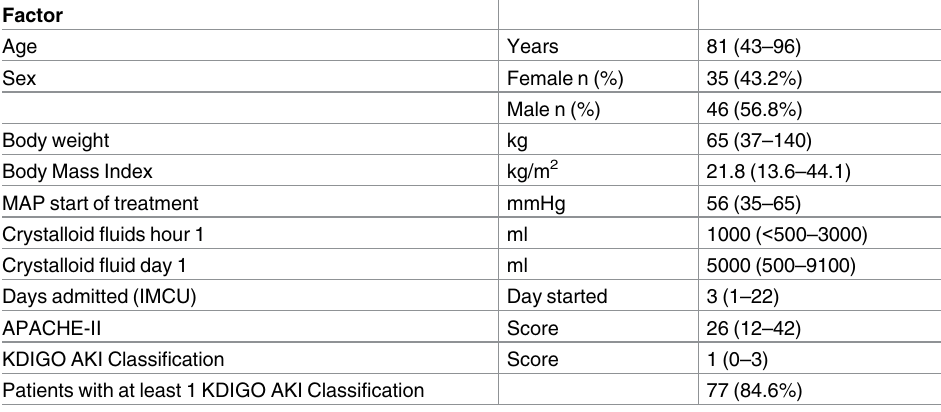
Table 1. Patient characteristics. Median and range or numbers and